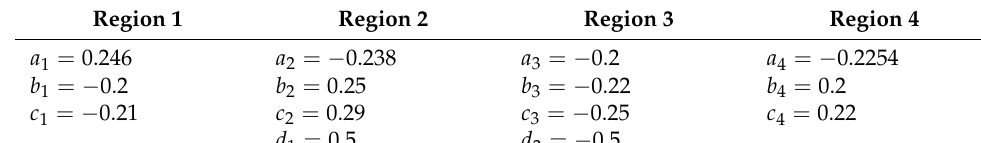
Table 1. Coefficients of the parameters depending on the case of infection reduction.